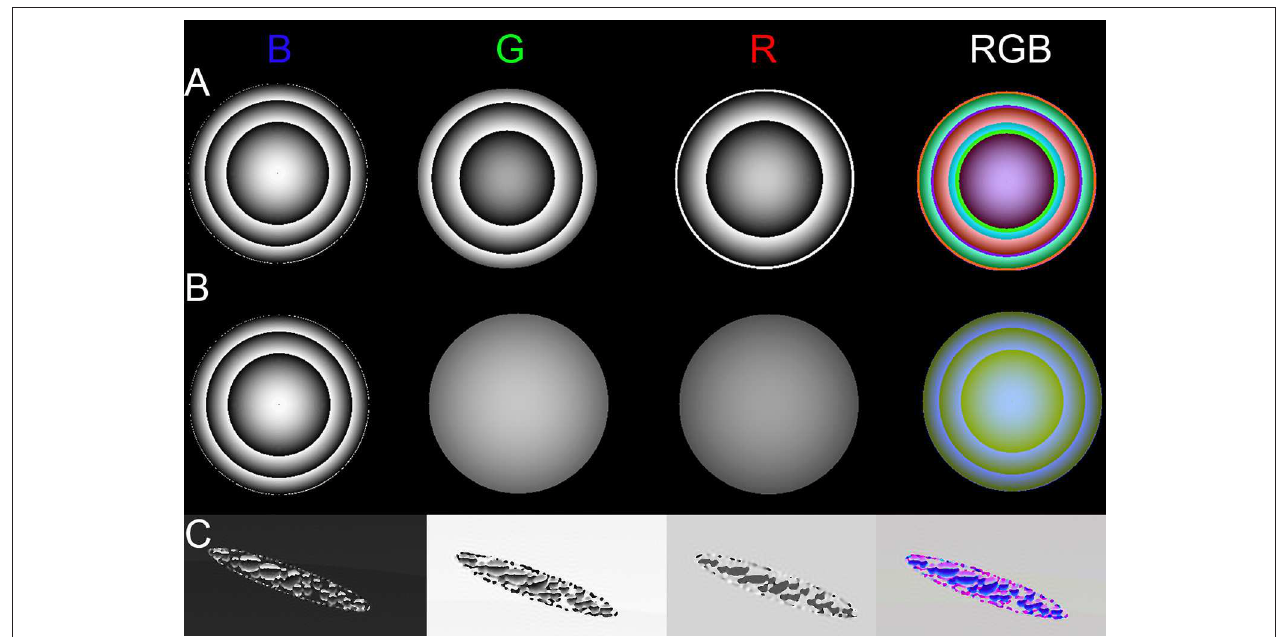
FIGURE 5 | Phase images of dispersive and non-dispersive red sphere and simulated Euglena . (A) Non-dispersive sphere with strong phase shift across all wavelengths. (B) Dispersive sphere, with a strong phase shift only in blue. (C) Phase of simulated (non-dispersive) Euglena